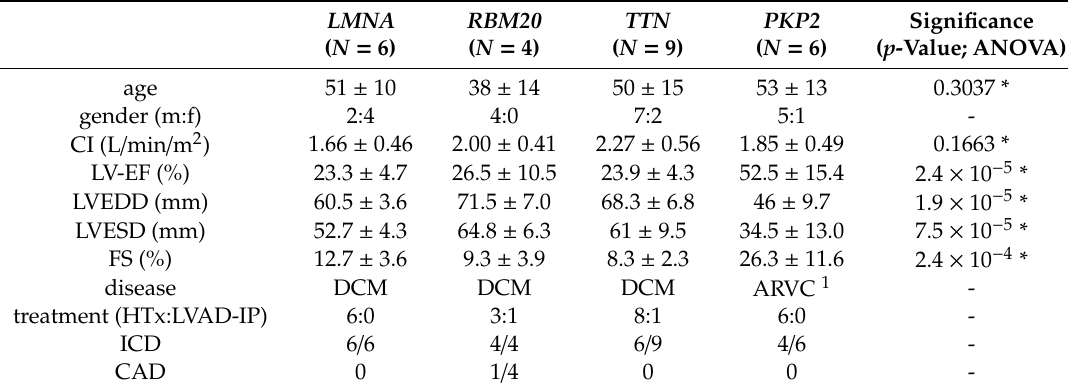
Table 1. Comparison of clinical findings of all sample